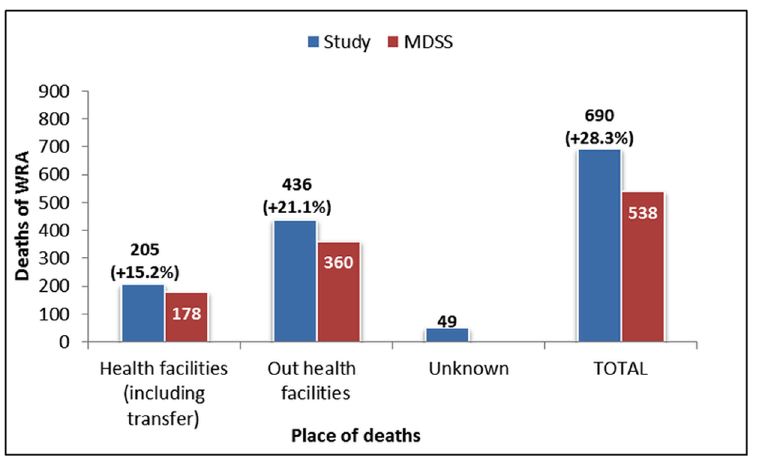
Fig 4. Deaths of WRA by place, identified by the study and the MDSS,